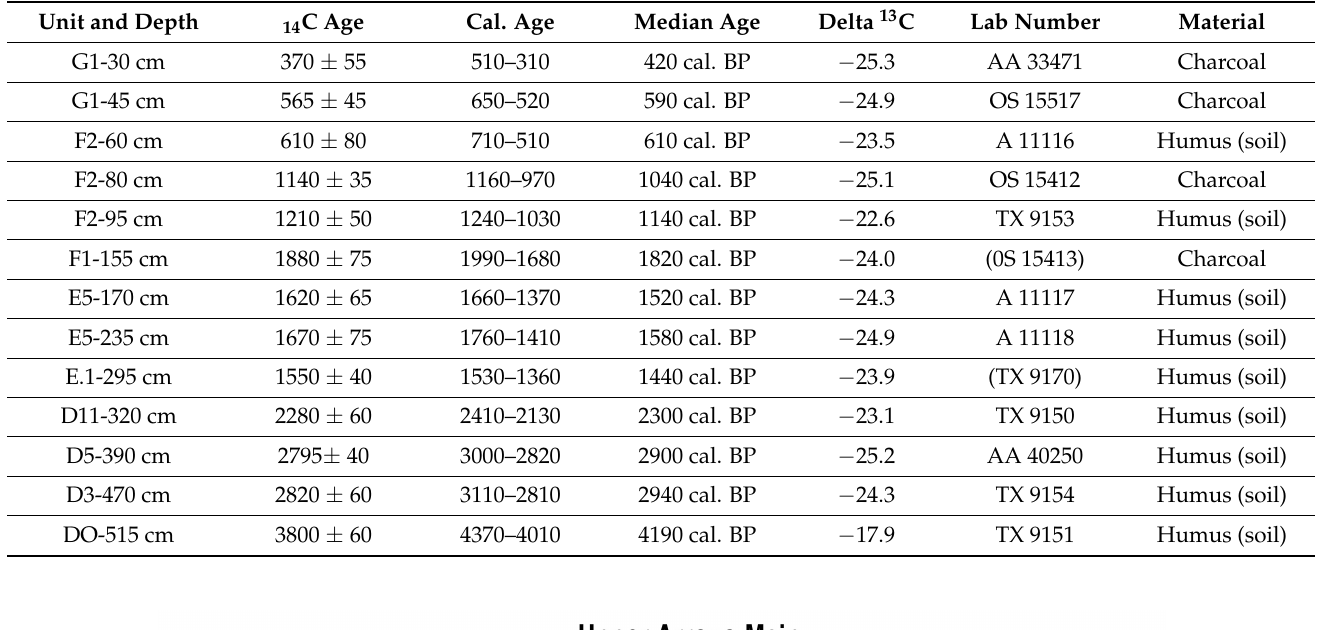
Table 3. Upper Arroyo. Main unit, upper part, radiocarbon, and AMS dates (rejected dates in